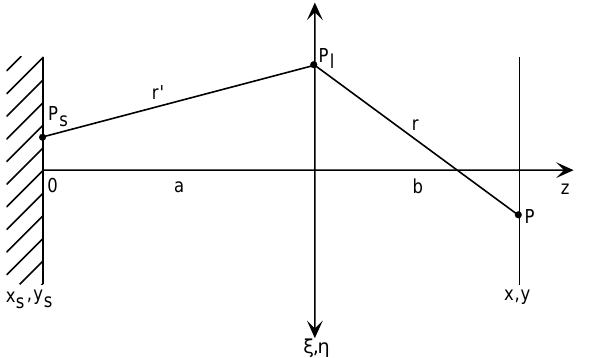
FIG. 3. Image of the OTR source is formed by a thin lens placed at distances (cid:97) and (cid:98) from the source plane (cid:115) (cid:120) (cid:115) (cid:44) (cid:121) (cid:115) (cid:100) and the image plane (cid:115) (cid:120) (cid:44) (cid:121) (cid:100)